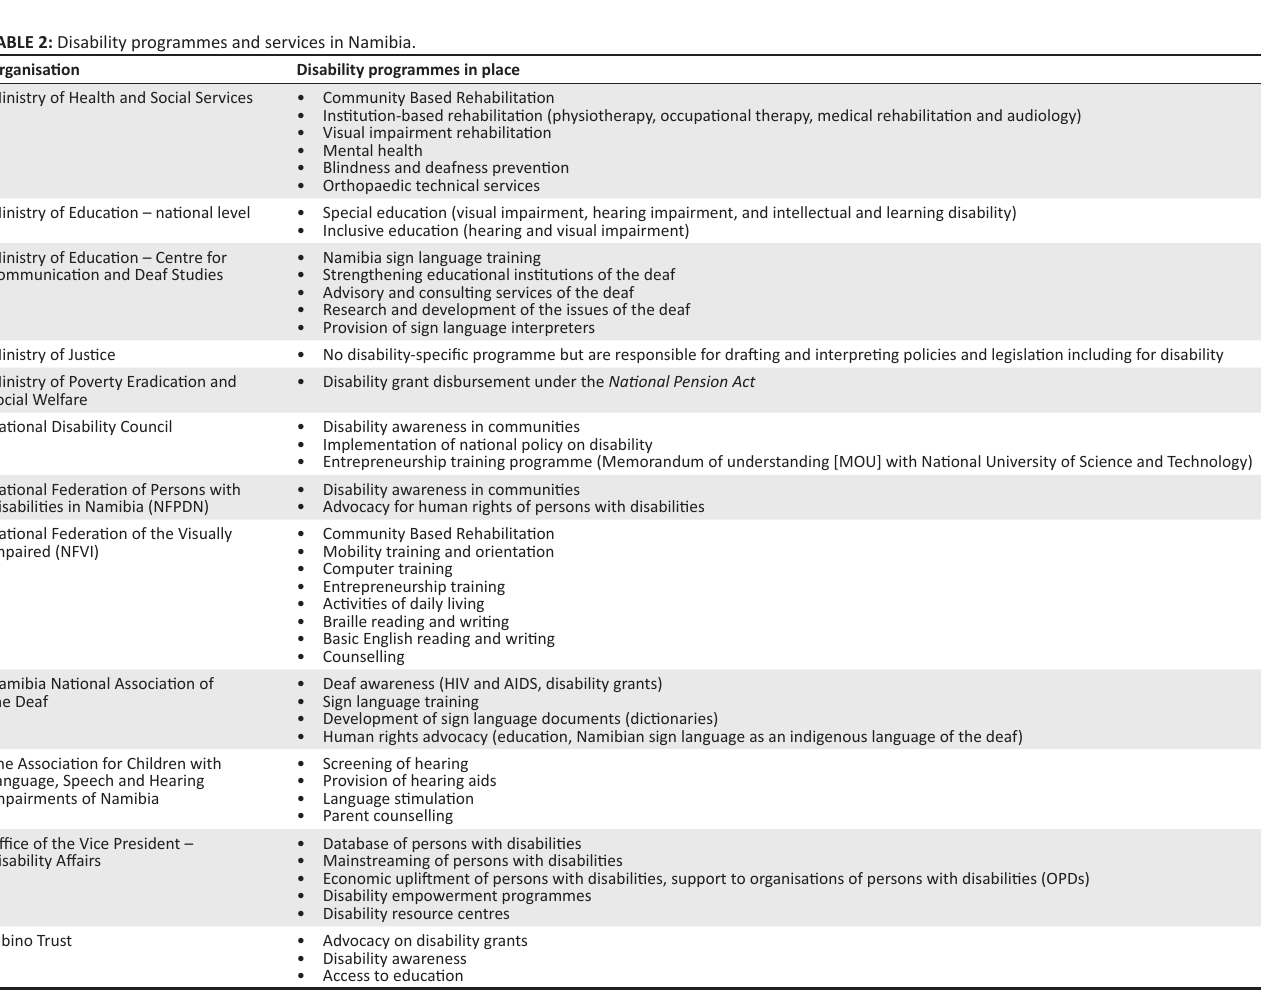
TABLE 2: Disability programmes and services in Namibia.